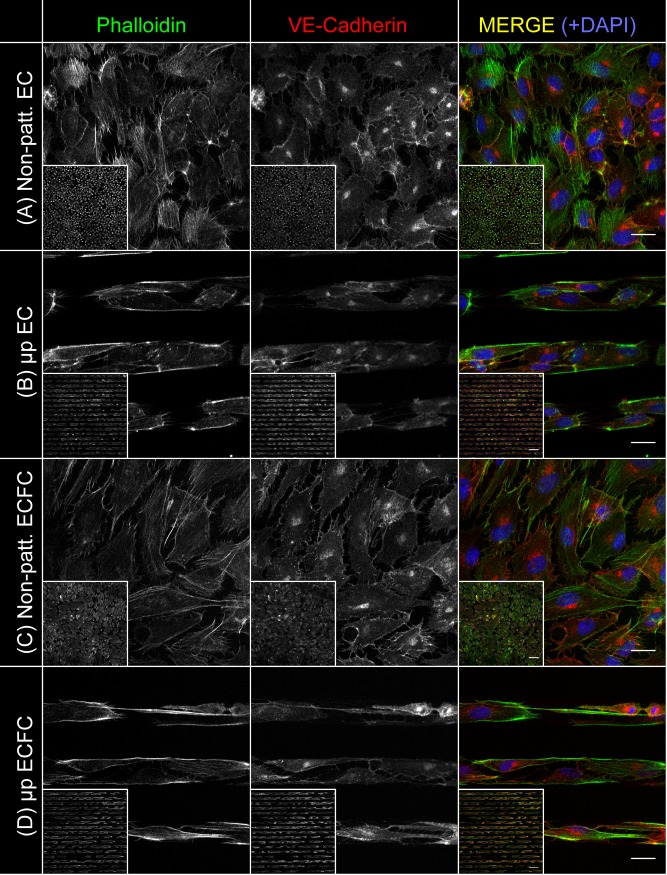
Micropatterned cells show subcellular alignment and peripheral aggregation of actin.ECFCs and ECs were stained and imaged using laser scanning confocal microscopy with a super-resolution airyscan detector in order to assess actin distribution and alignment after 24 hours of culture. Representative images of non-patterned ECFCs (A), micropatterned ECFCs (B), non-patterned ECs (C), and micropatterned ECs (D) after 24 hours in culture are shown. Each image series shows phalloidin (actin), VE-Cadherin, and a pseudocolor merge with phalloidin in green, VE-Cadherin in red, and a DAPI nuclear stain in blue. Main panel scale bars are 20 μm. Inset panels are 10X maximum Z-projections, with scale bars of 100 μm.